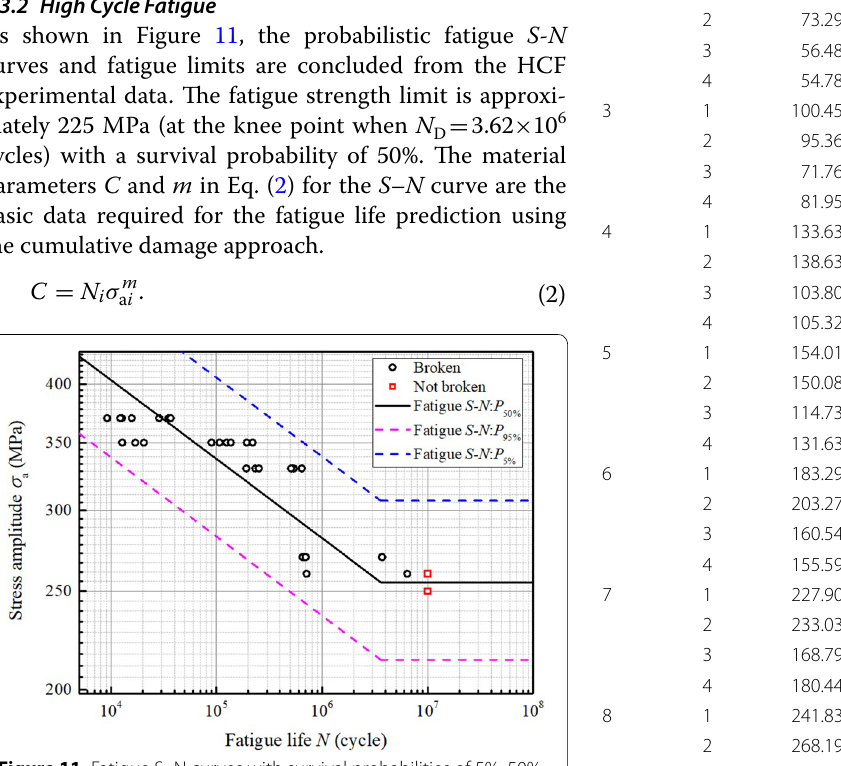
Figure 11 Fatigue S–N curves with survival probabilities of 5%, 50%, and 95% for weathering